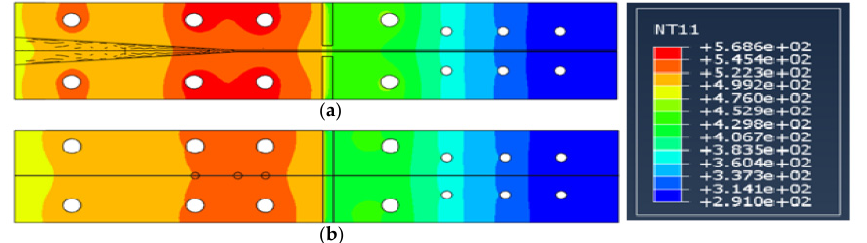
Figure 8. ABAQUS ® simulation where: ( a ) Cross section view of the middle of the die; ( b ) side view of the die. NT11 represents the temperature in Kelvin